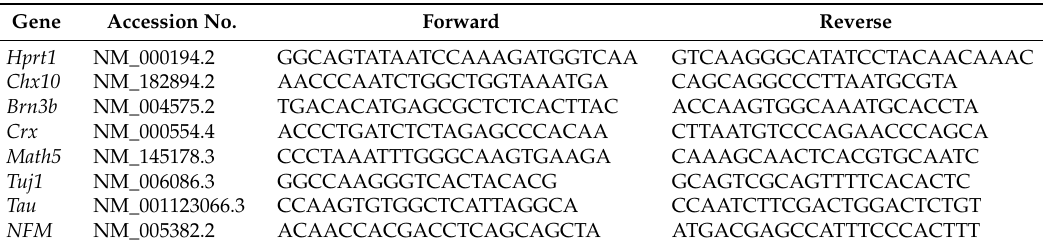
Table 2. Primers for real time